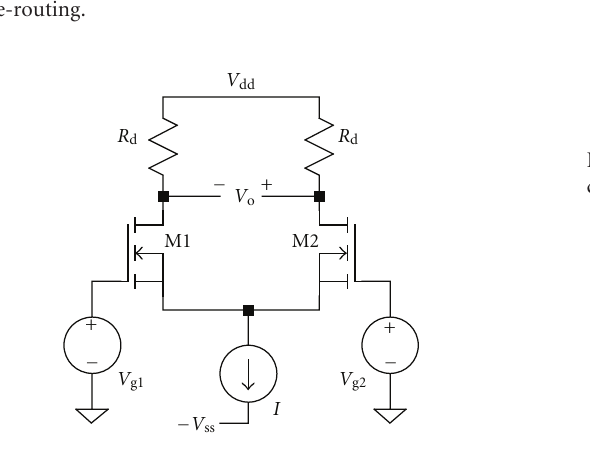
Figure 7: Bias distribution circuit using both current-routing and voltage-routing.